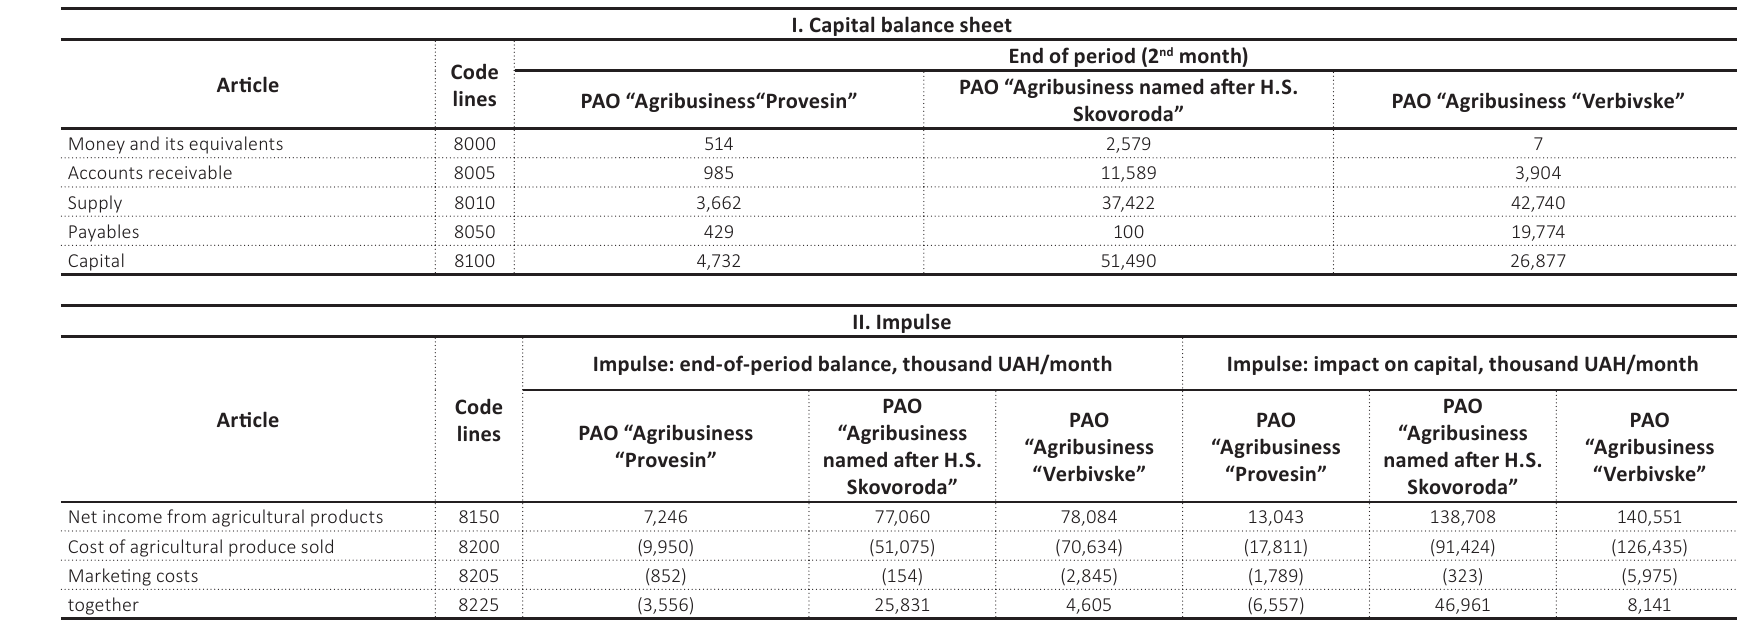
Source: Developed by the authors based on SMIDA (2020) and Samusenko